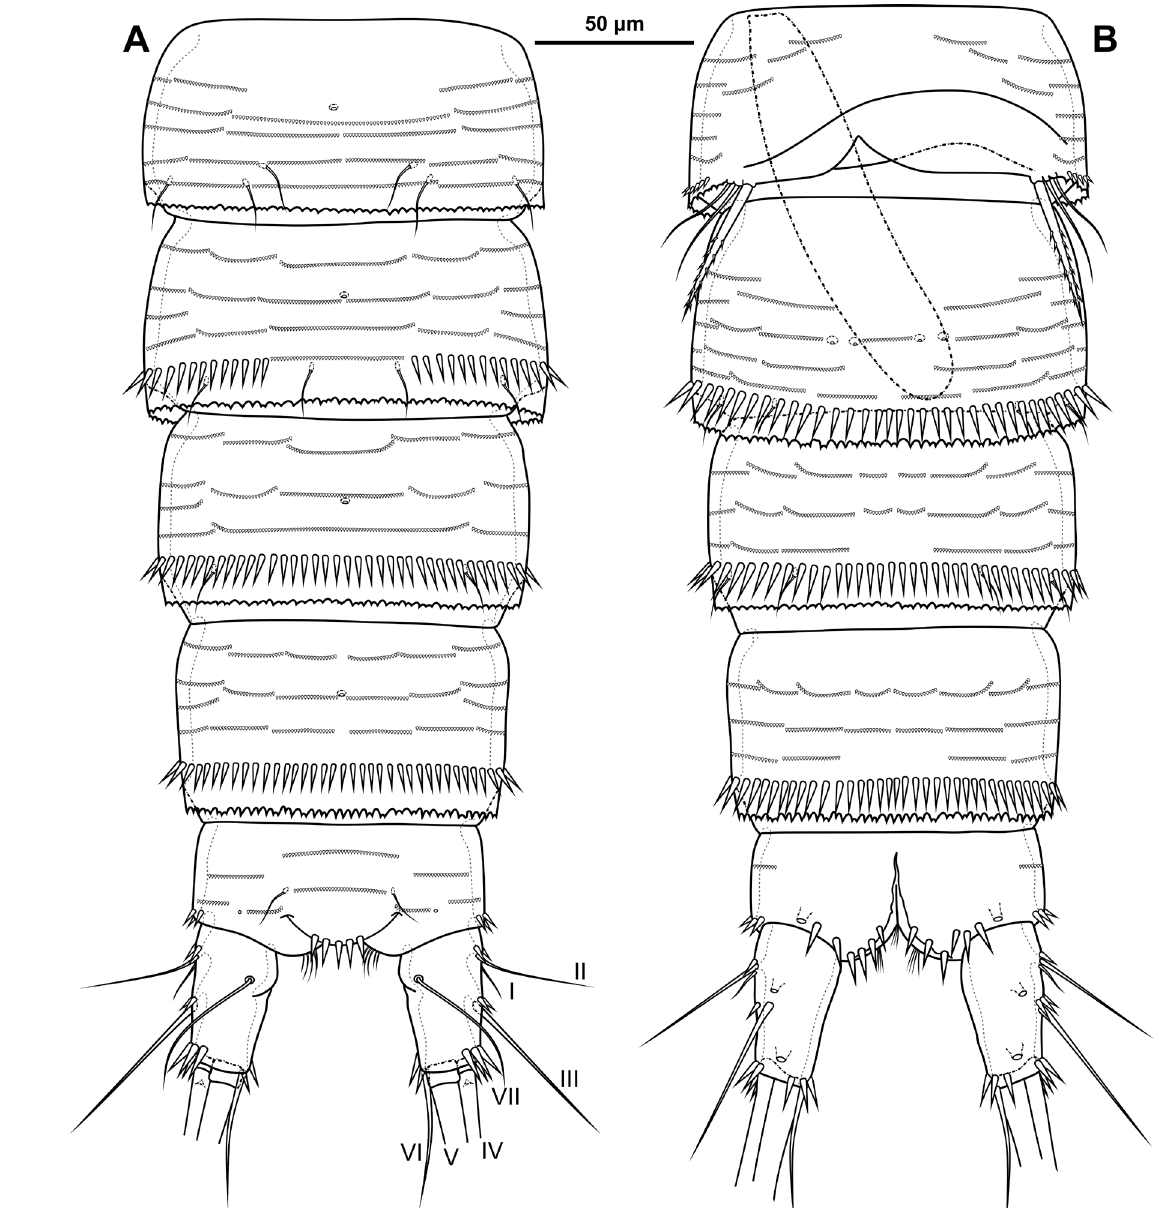
Fig. 7. Canthocamptus waldemarschneideri sp. nov., allotype, ♂ (KFU BP 544/2). A . Abdomen, dorsal view. B . Abdomen, ventral